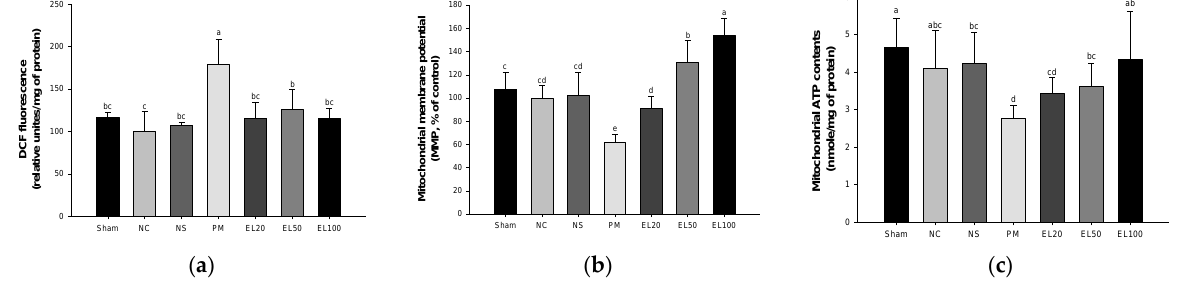
Figure 5. Protective effect of extract of Lonicera japonica on PM 2.5 -induced biochemical changes related to the mitochondrial function. ( a ) Mitochondrial reactive oxygen species (ROS) contents; ( b ) Mitochondrial membrane potential (MMP) levels; ( c ) Mitochondrial ATP contents. Results shown are mean ± SD ( n = 5). Data were statistically represented at p < 0.05, and different lowercase letters indicate statistical significance.